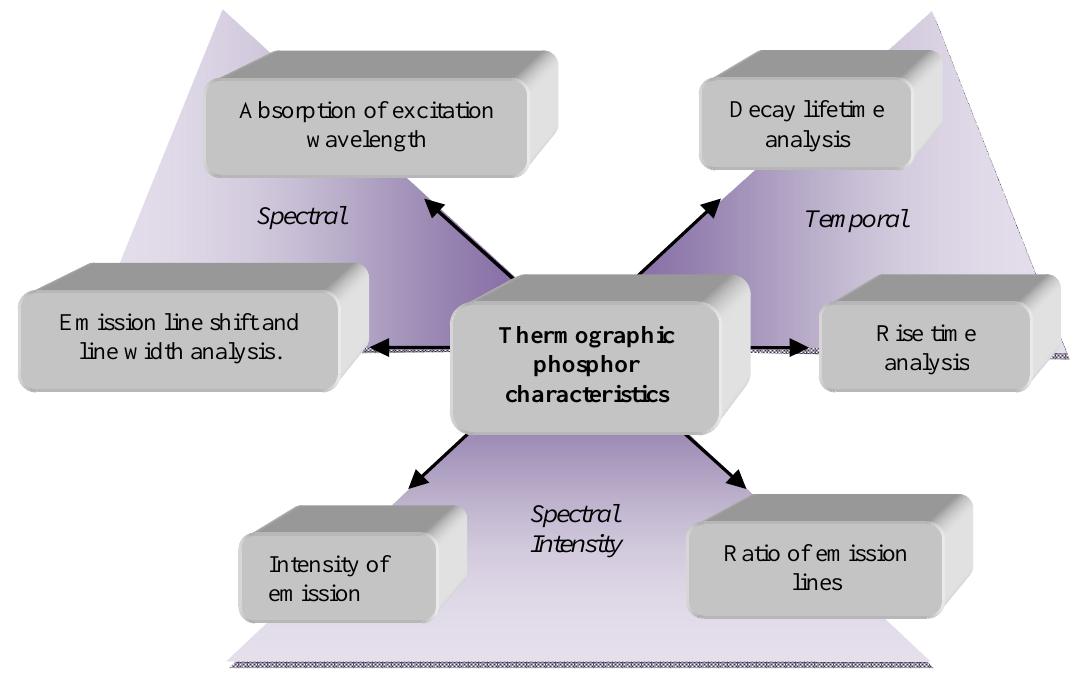
Figure 6. Different response modes for thermographic